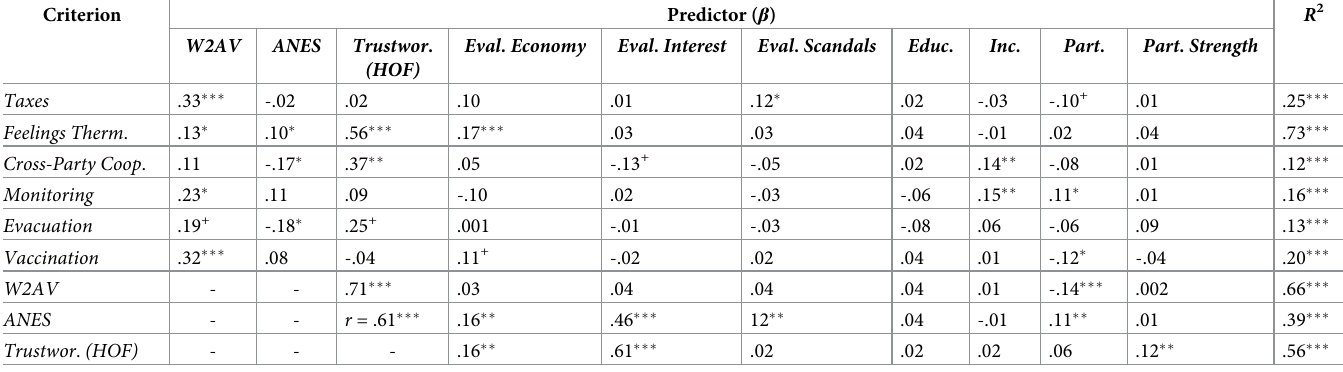
Table 4. Saturated structural equation model